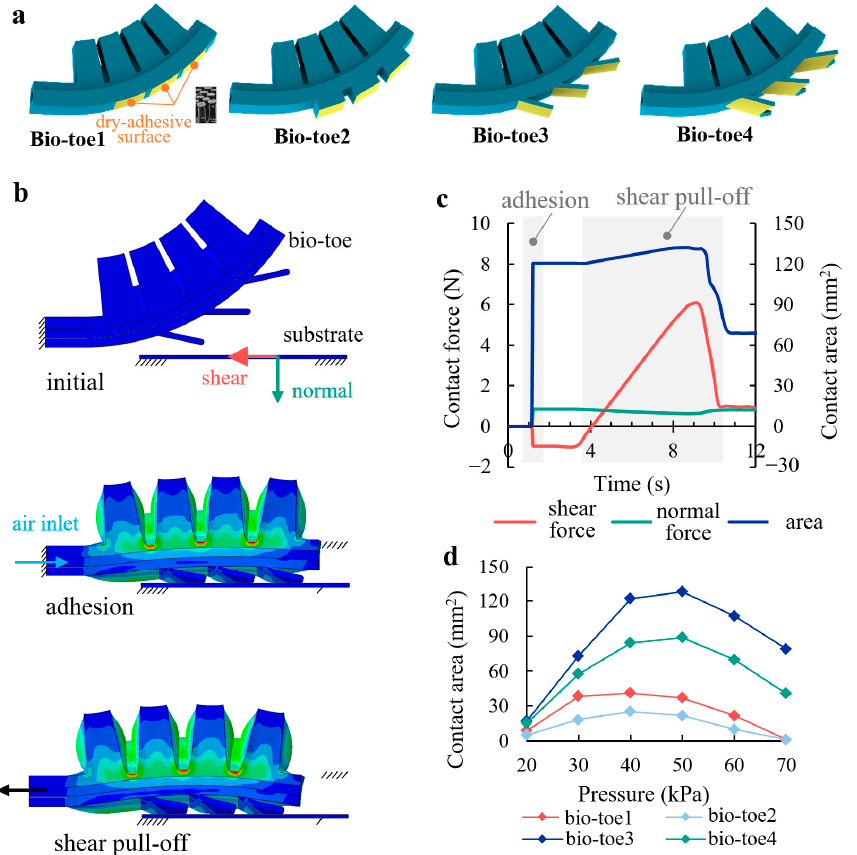
Figure 4. ( a ) Four types of bio-toes. ( b ) Finite element model of bio-toe3 during adhesion to and shear pull off from the flat surface. ( c ) Simulation results of the contact behavior and mechanical properties. ( d ) Contact areas of the four bio-toes in adhesion versus applied